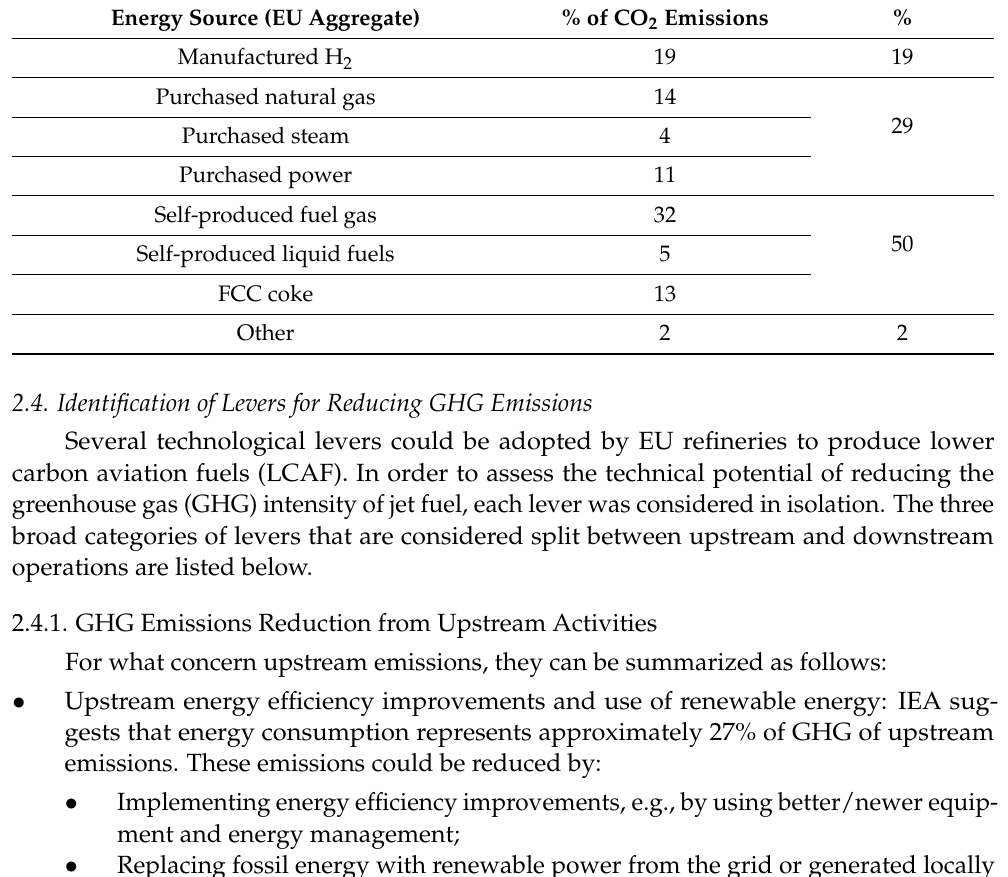
Table 3. Distribution of EU aggregate CO 2 emissions from Downstream Oil